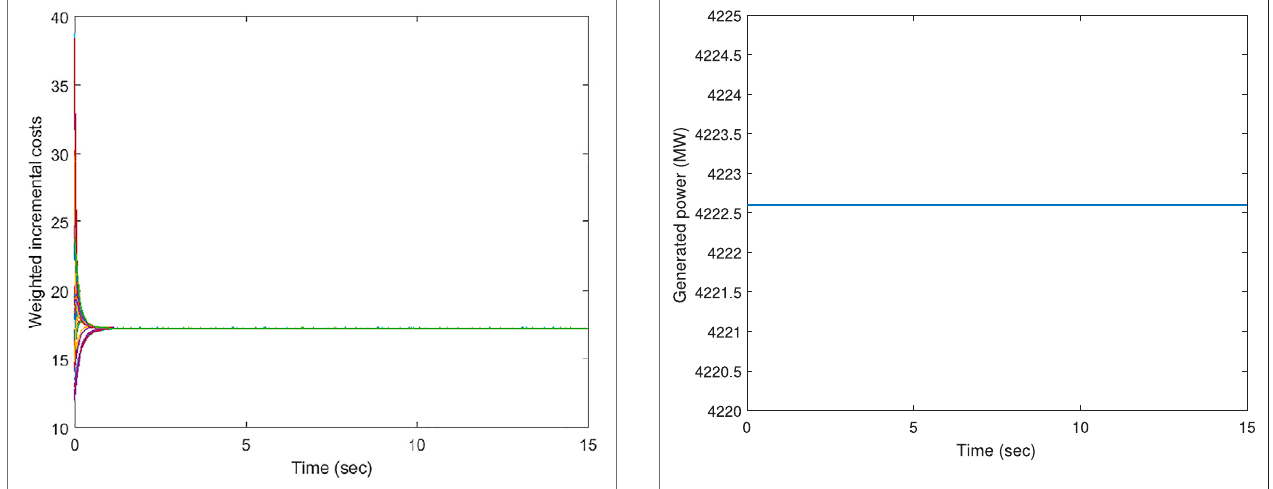
FIGURE 7 | IC consensus for unity weights of IEEE-118 bus system.